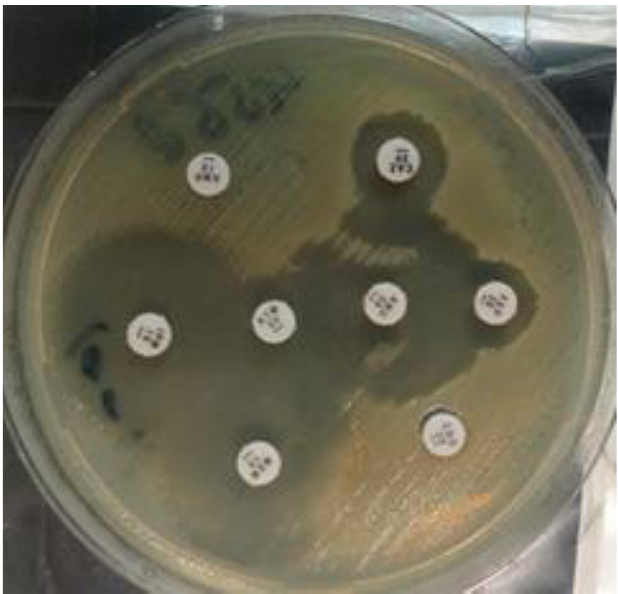
Figure 9. Double disc diffusion method for ESBL producing E. coli.